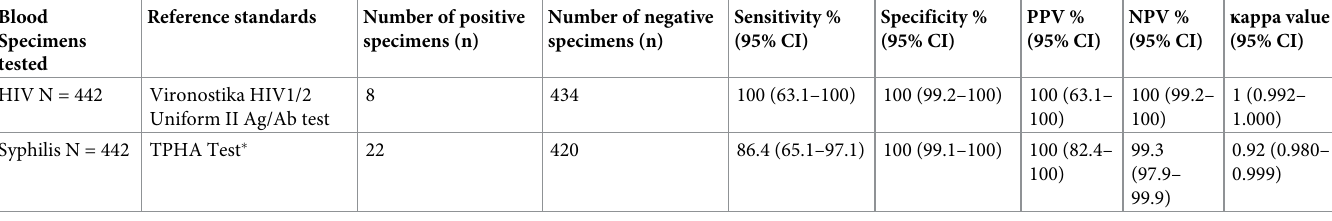
Table 1. Diagnostic accuracy of the SD Bioline Duo HIV/syphilis assay among pregnant women attending ANC in Juba, South Sudan. Blood